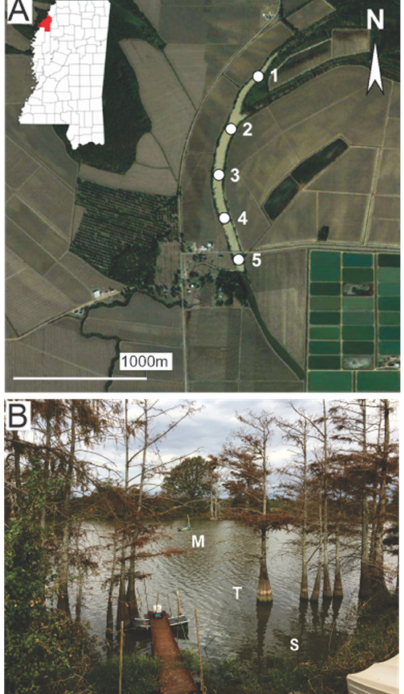
Figure 1. ( A ) Five sample sites (filled circles) established longitudinally from north (upstream) to south (downstream) within Roundaway Lake, Coahoma County, Mississippi, USA. ( B ) Photograph of Roundaway Lake site 3 showing the bald cypress ( Taxodium distichum (L.) Rich.) tree line and relative spacing of mid-lake (M), tree line (T), and shore (S) sediment